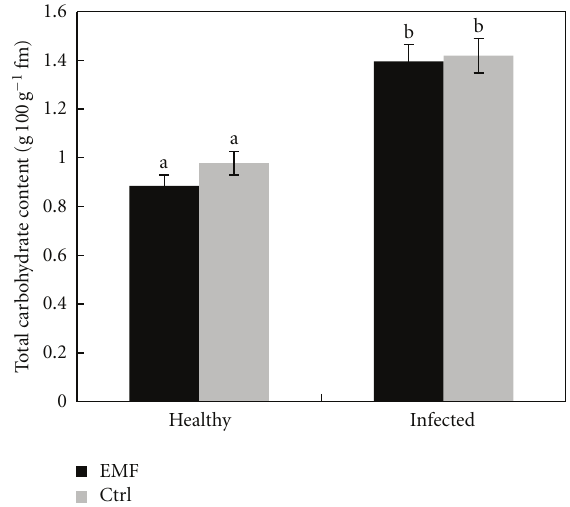
Figure 3: E ff ect of EMF on carbohydrates content in healthy and infected plants of Citrus aurantifolia. Vertical bars indicate mean ± SE of three replicates. Di ff erent letters indicate significant di ff er- ences ( P < 0 . 05).